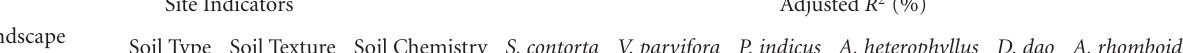
Table 6: Stepwise multiple regressions analysis to explain growth performance in relation to site indicators.